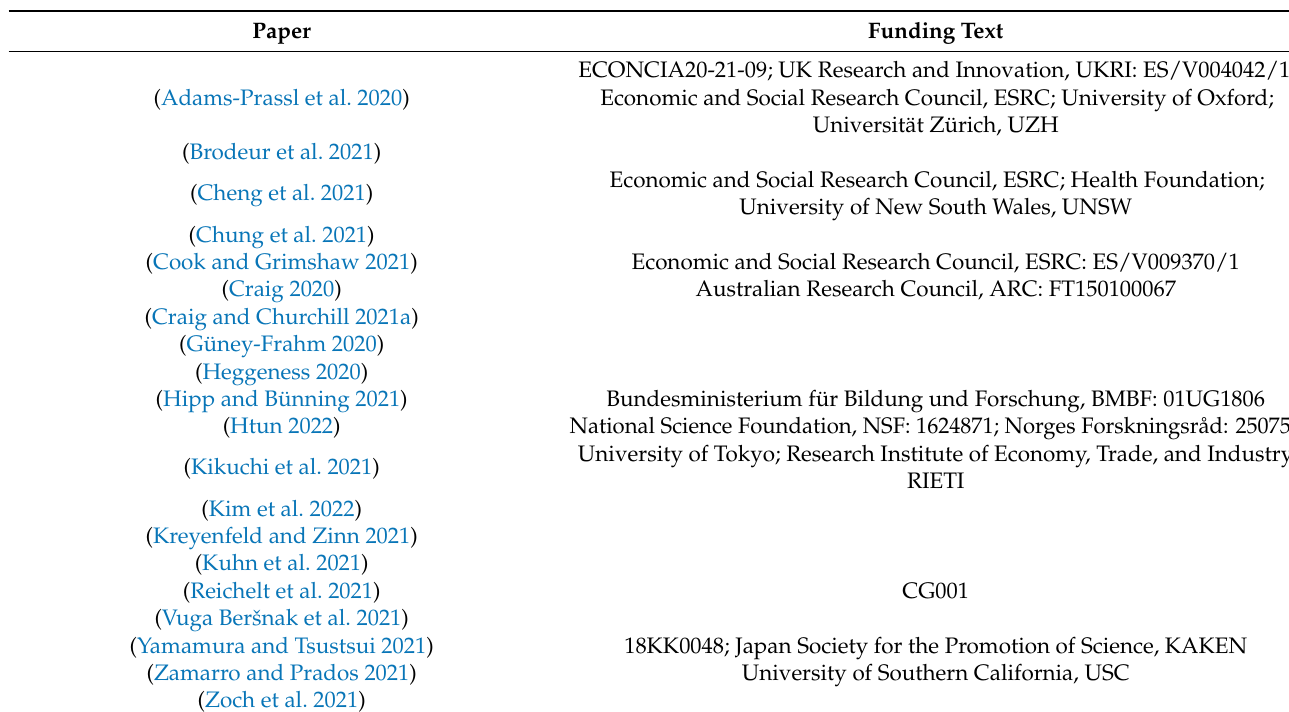
Table 4. Funding text stated by authors in Scopus for each